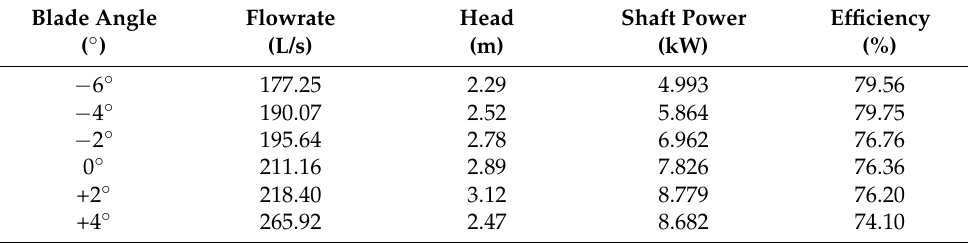
Table 3. Optimal efficiency point parameters of the pump under different blade angles. Pumping device prototype design of net head and maximum net head critical cavitation